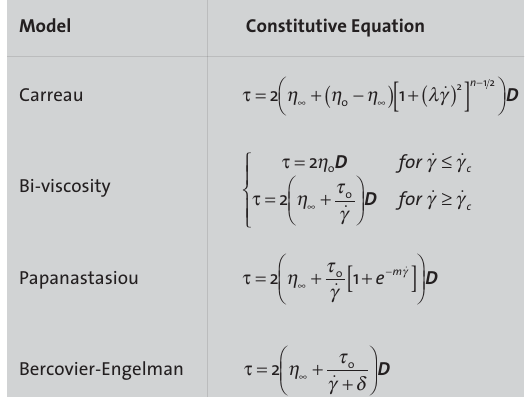
Table 2 (right): Viscosity